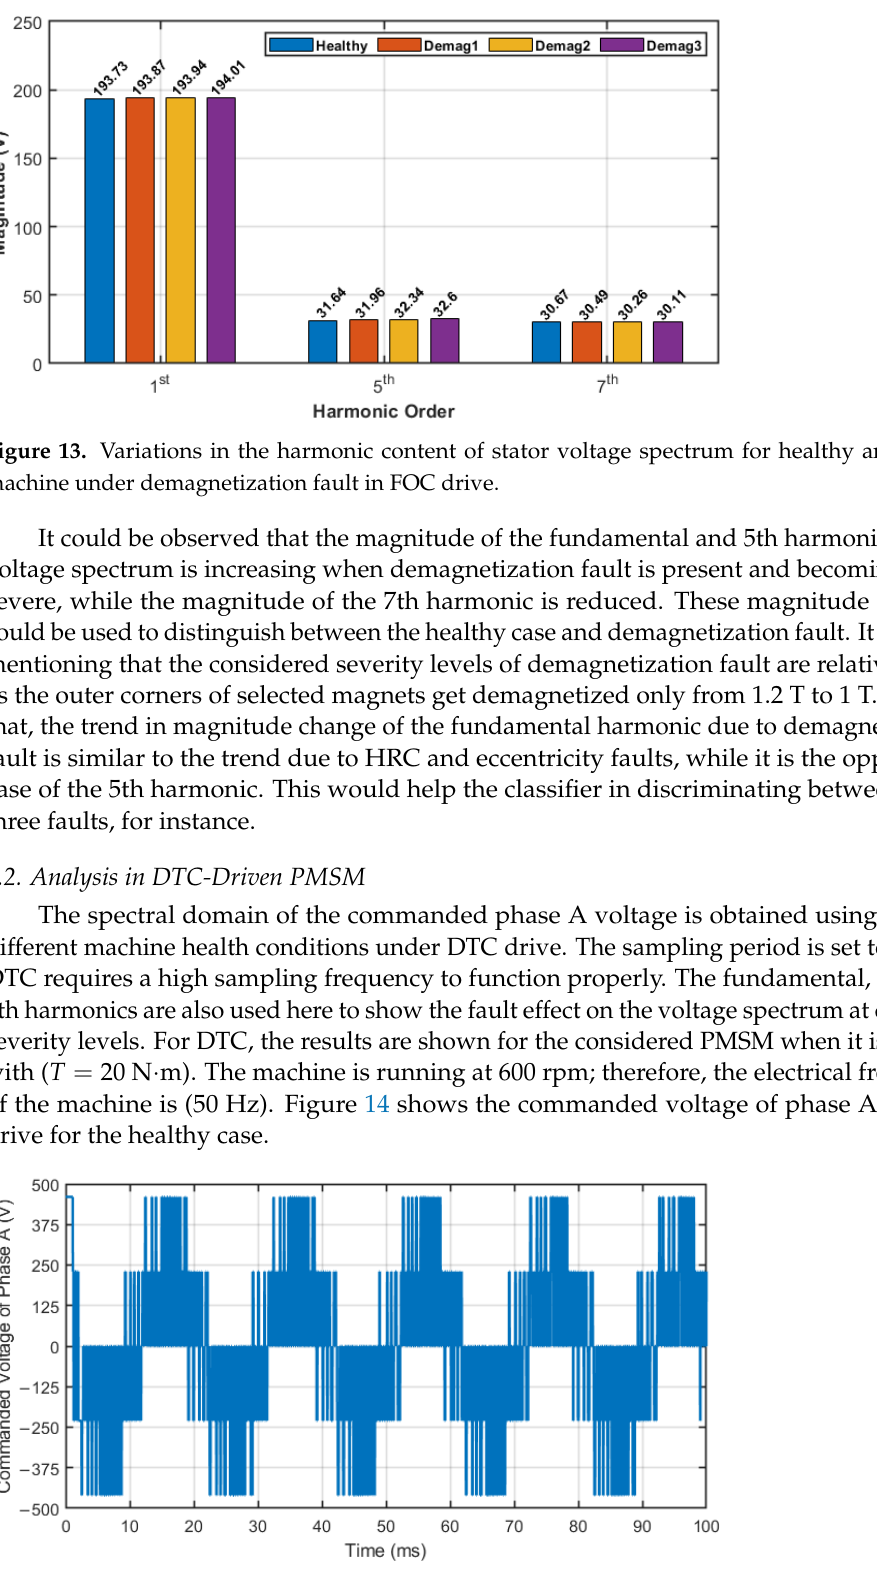
Figure 14. The commanded voltage of phase A in DTC